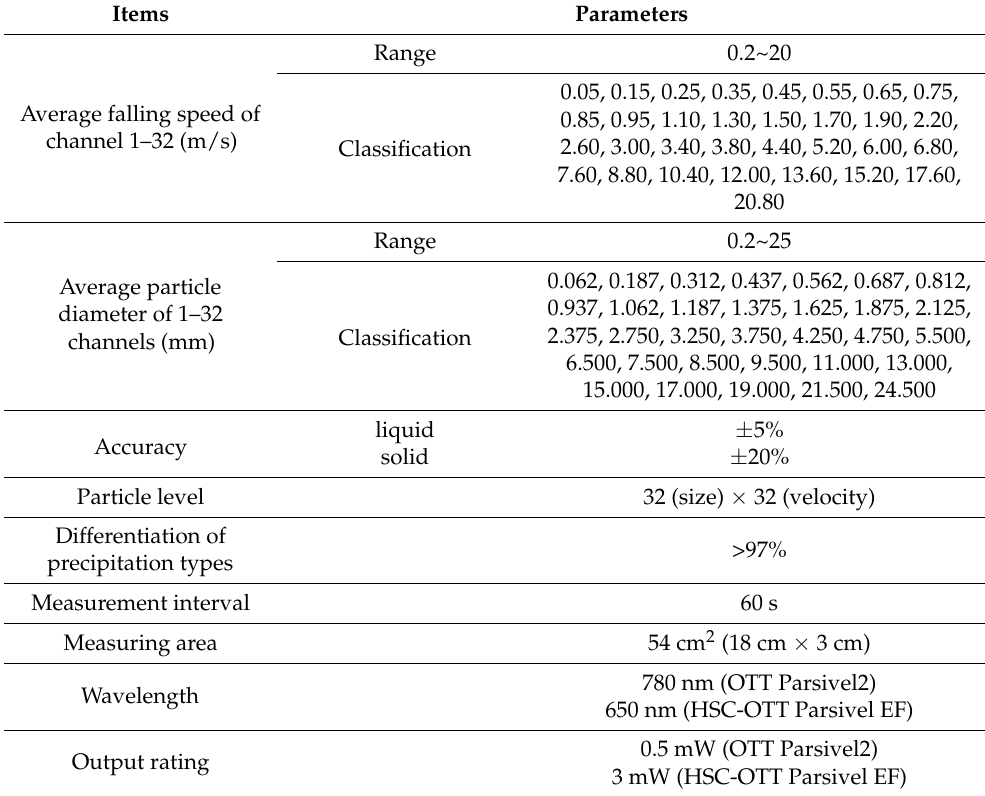
Table 1. The performance parameters of the raindrop